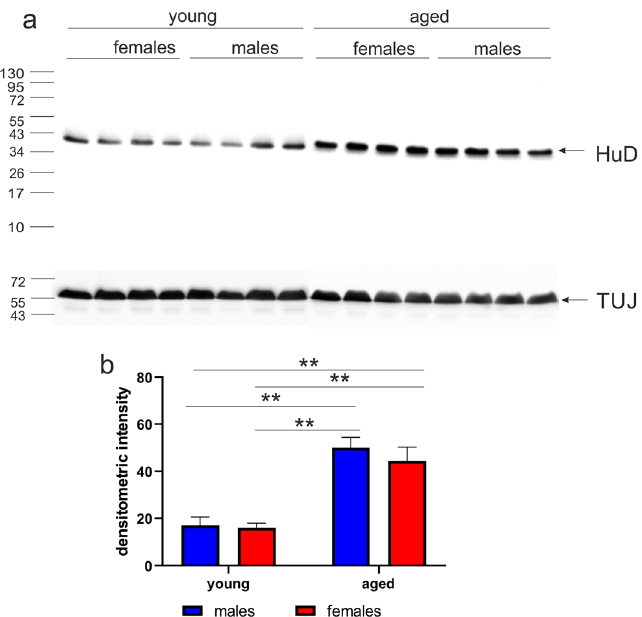
Figure 7. The level of HuD protein in the olfactory bulb (OB) of opossums. ( a ) Each labeled band in Western blot shows the amount of HuD in an individual opossum OB. Beta-III tubulin (TUJ) was used as a loading control (Supplementary Fig. S2a). ( b ) Quantification of HuD from Western blots. **Indicates p <